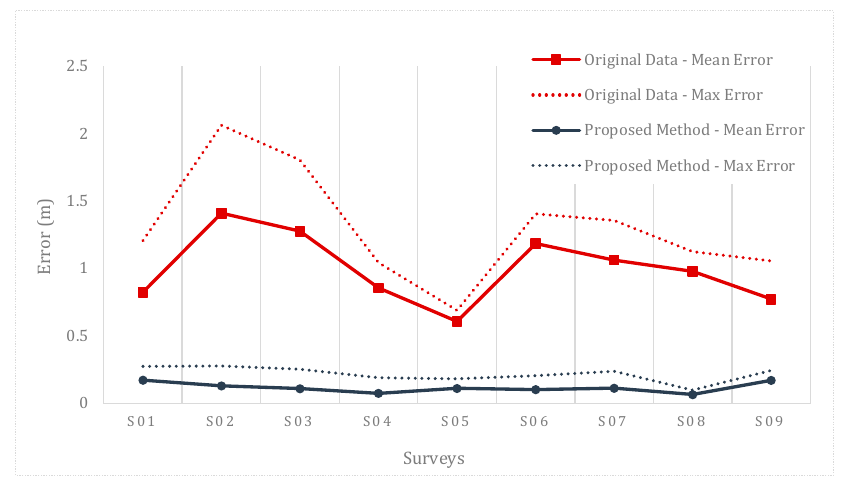
Figure 28. Total 2D error of the nine surveys in the original data and by the proposed method.